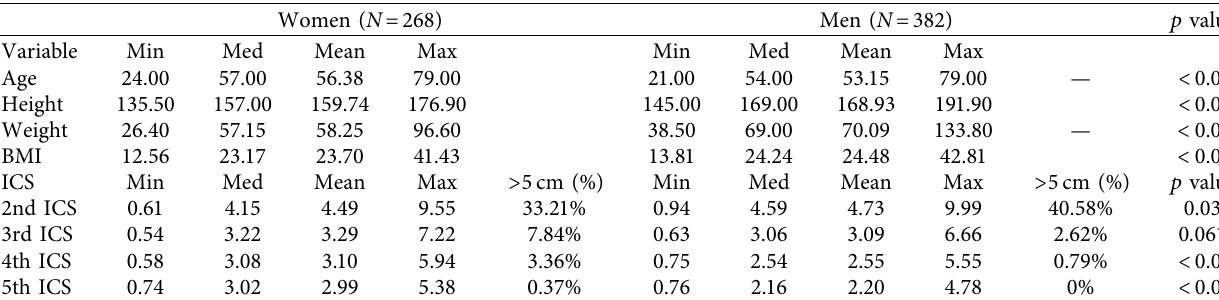
Table 1: Participant